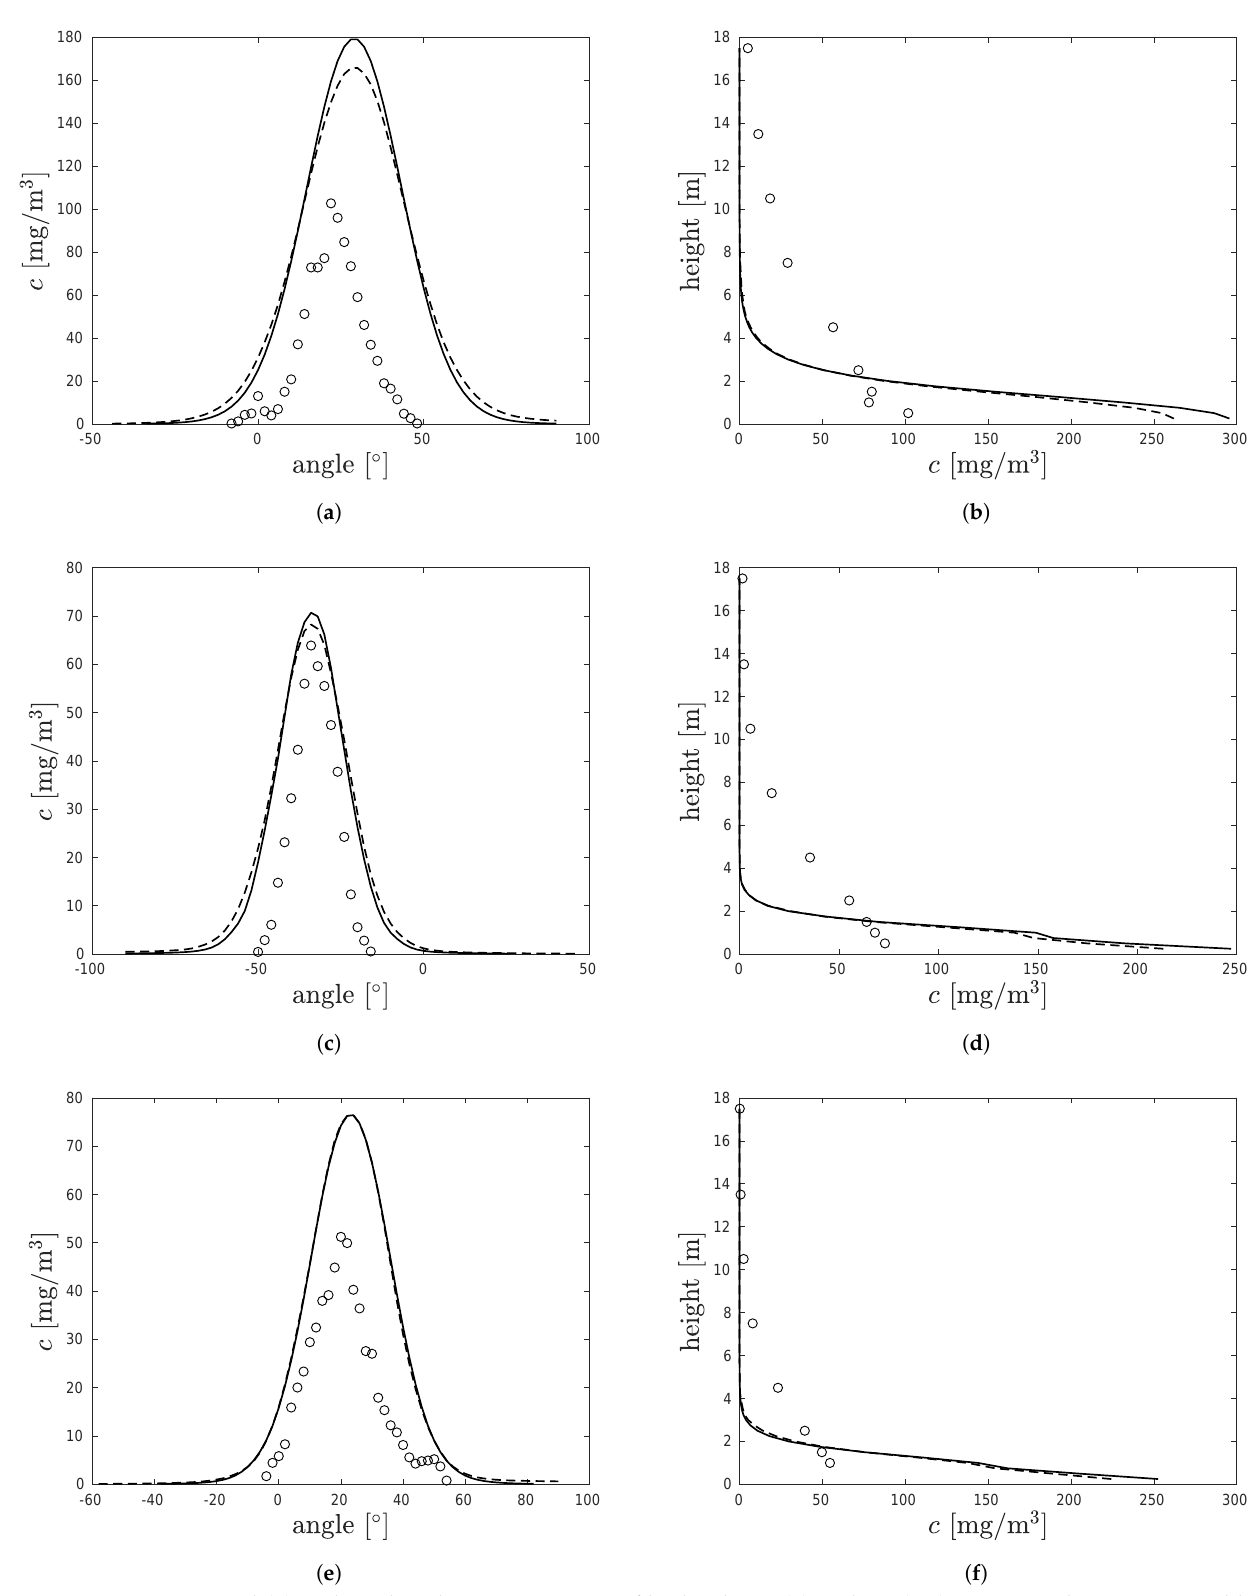
Figure 4. Measured ( ◦ ) and predicted concentration profiles by the PI (–) and KS (– –) estimator during an unstable stratification at the 100m-arc for ( a , b ) experiment 15 ( c , d ) experiment 34 ( e , f ) experiment 61 with n p = 1000 particles per release time and ∆ t ∗ = 0.01. For each experiment, the vertical profile from the tower closest to the wind direction is